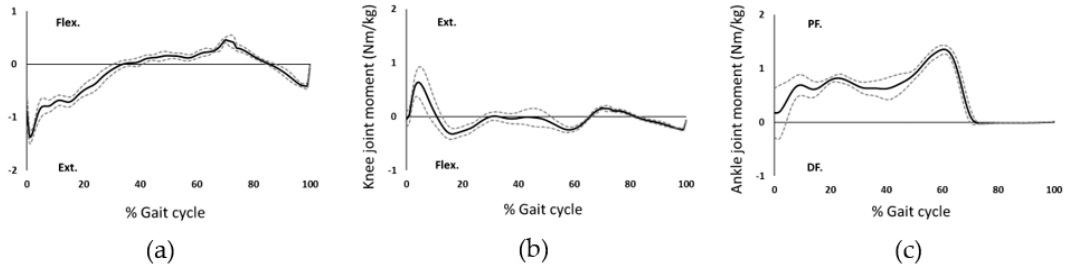
Figure 11. Moments of the ( a ) hip, ( b ) knee, and ( c ) ankle joint of the intact leg. The solid and dashed lines indicate the mean values and standard deviations, respectively. Positive values in the moments indicate hip flexion moment (Flex.), knee extension (Ext.), and ankle plantar flexion moment